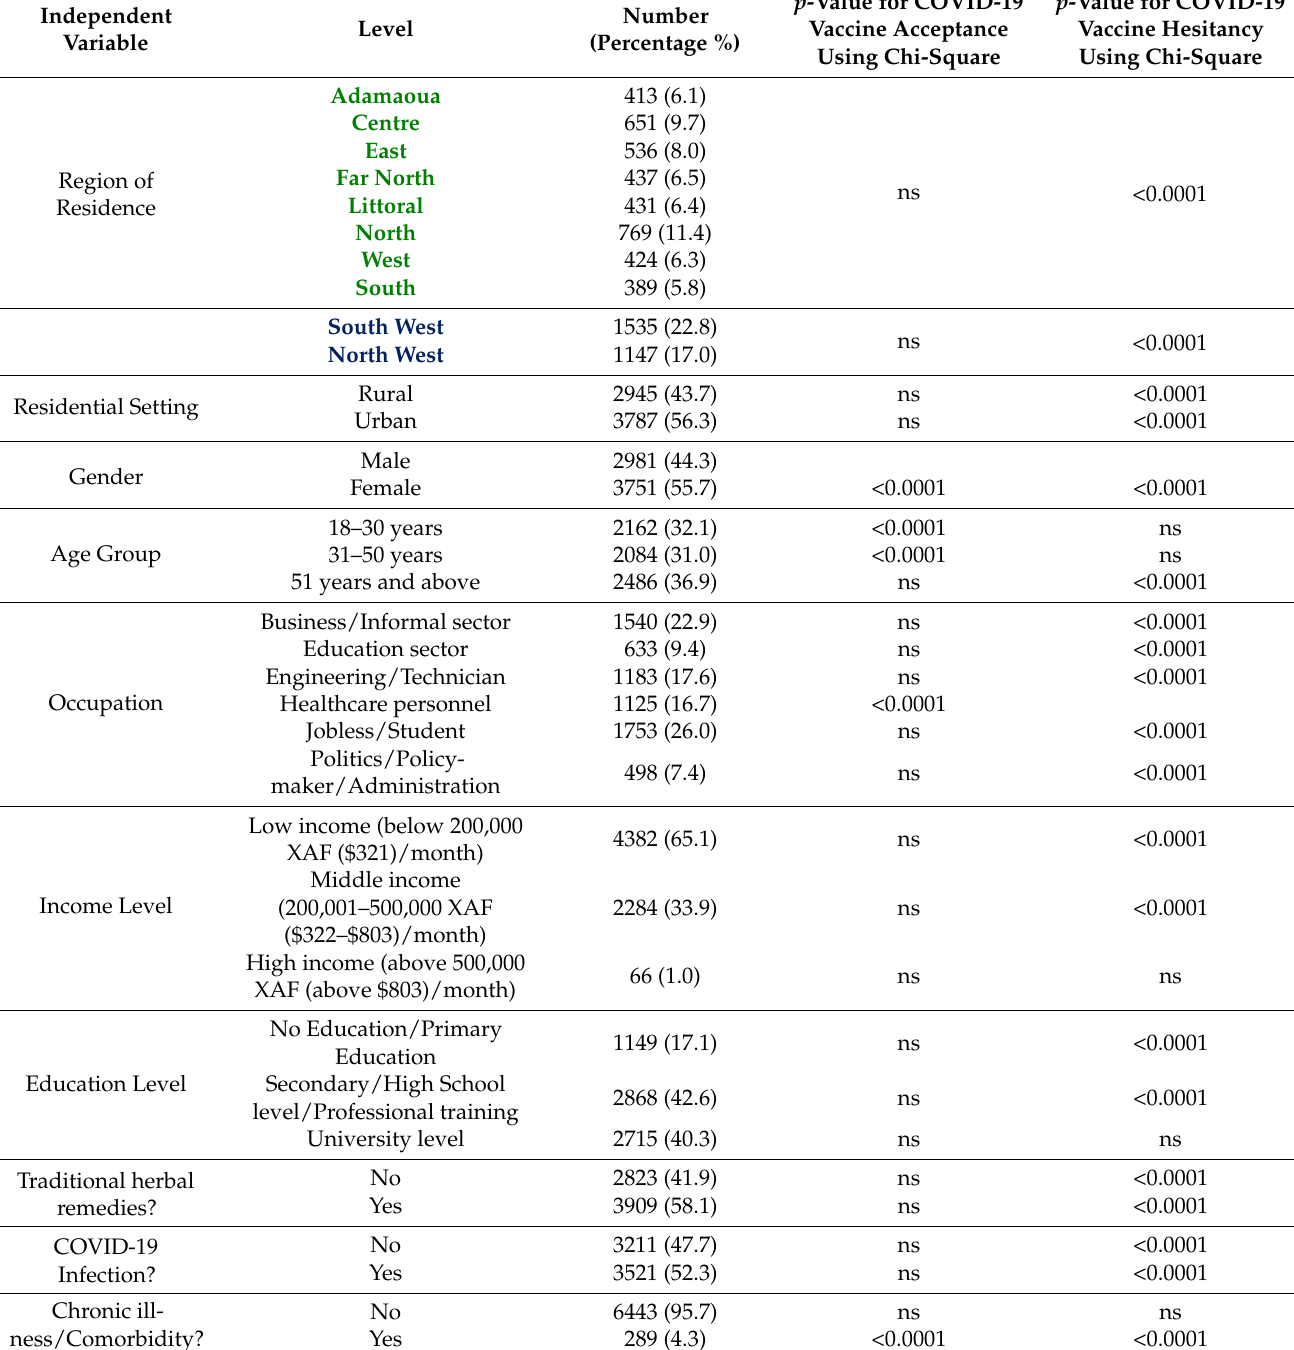
Table 1. Socio-economic demographic characteristics of the study population. The Chi-square test was used to determine which variable level of the dichotomized variables indicated either an acceptance or hesitancy to a COVID-19 vaccine in a statistically significant manner.